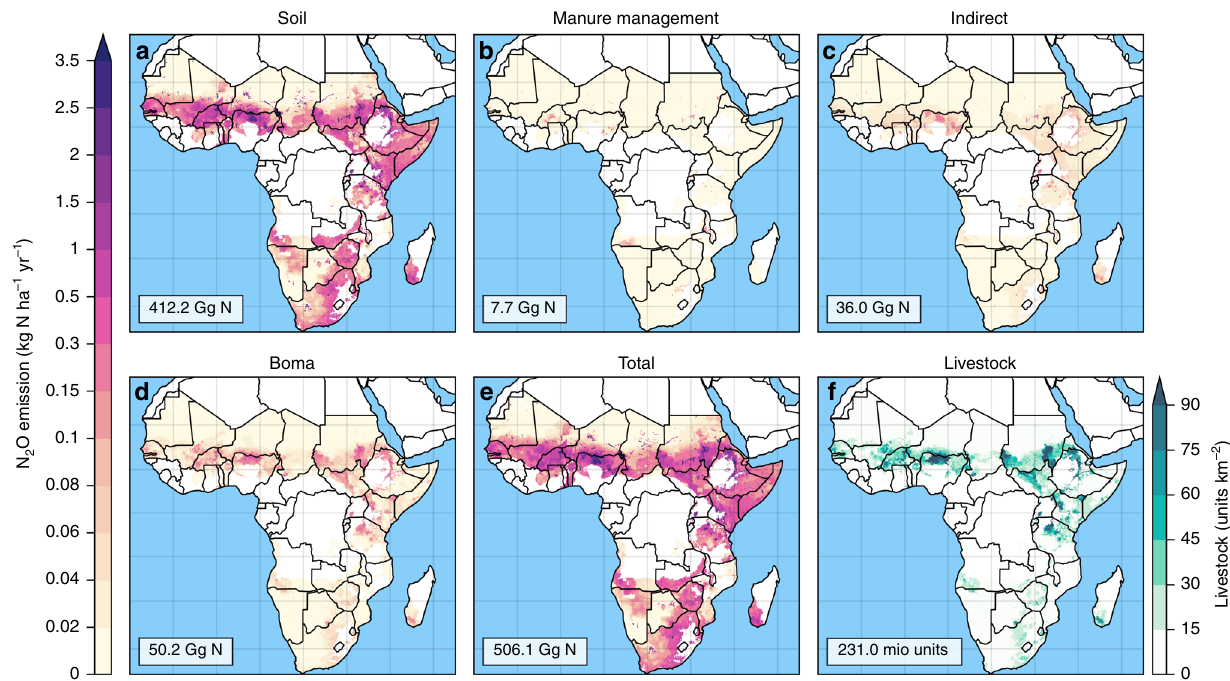
Fig. 4 Sources of agricultural N 2 O fl uxes and livestock units. Given are N 2 O fl uxes for semi-arid and arid regions in SSA based on EDGAR5 5 ( a : soil; b : manure management; c : indirect emissions) and the total N 2 O emissions from bomas d from this study, and the resulting sum of total agricultural N 2 O emissions ( = a + b + c + d) e . f depicts the livestock density for cattle, sheep, and goats in semi-arid and arid environments in Africa 6 . Livestock units 23 (cid:2) (cid:3) P summarize total number of cattle, sheep, and goats with N ¼ cattle þ sheep (cid:2) 0 : 1 þ goats (cid:2) 0 : 1 0 : 7